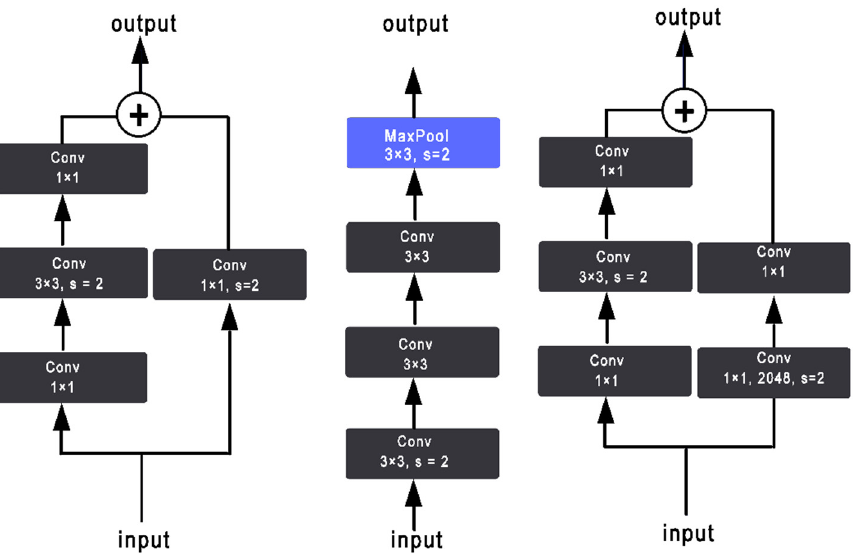
Figure 3. Three ResNet methods. ResNet-B modifies the downsampling block of Resnet. ResNet-C